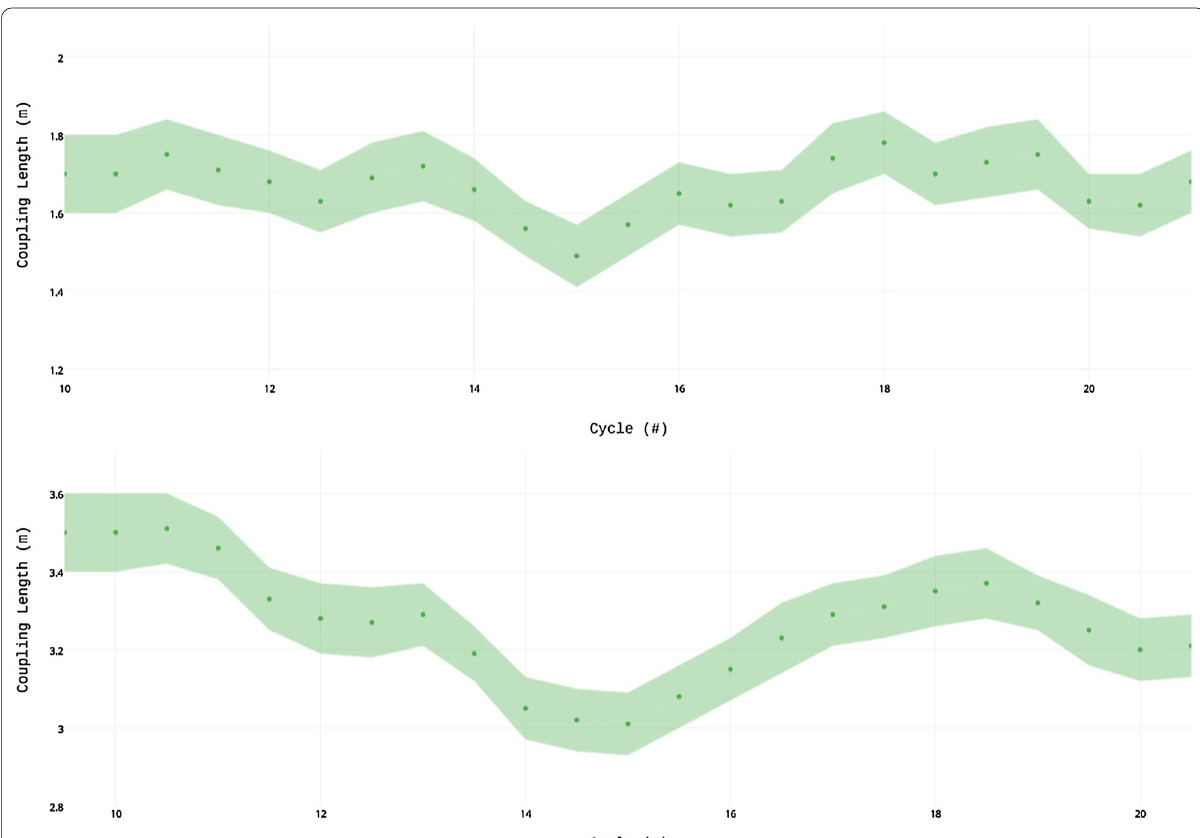
Fig. 17 Two trials for which coupling length is computed along the BEB-500-S1 trackway for a G2 walk ( LP G2-1-60 gait with track separation of 1 (refer to Fig. 6 for the track configuration corresponding to G2-1) . Lower: the same trackway and gait but for G2-2-60 (i.e., a track separation of